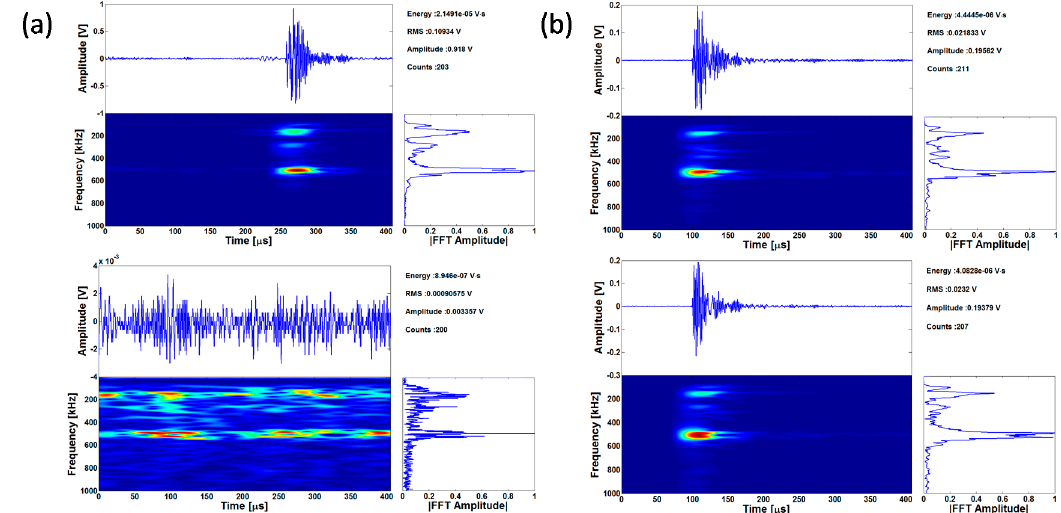
Figure 13. ( a ) Randomly selected signals from class 8 in Figure 12 showing both continuous and burst type emissions; ( b ) randomly selected signals from reclustered class 8 containing only burst emissions.